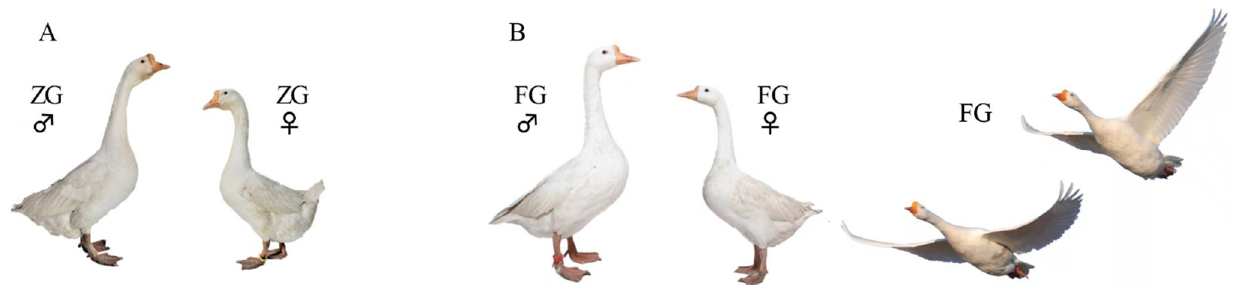
Figure 1. Pictures of ( A ) Zi geese and ( B ) Xianghai flying geese.